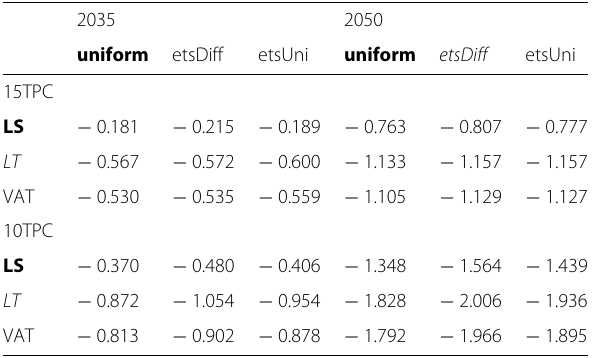
Table 8 Social welfare for different years and